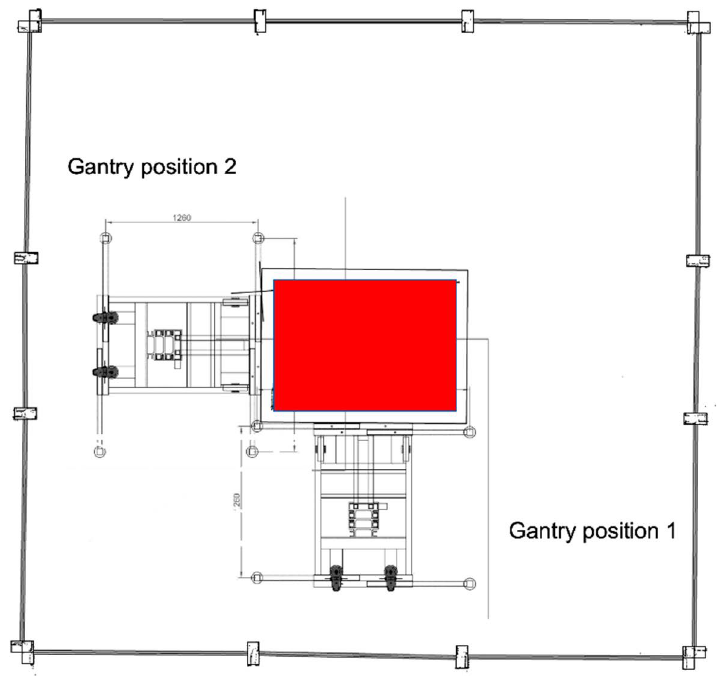
Figure 5. Top view map of the David’s surrounding the area with two examples of scanning positions.